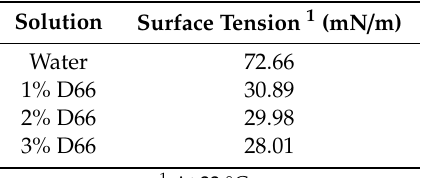
Table 7. Surface tension.